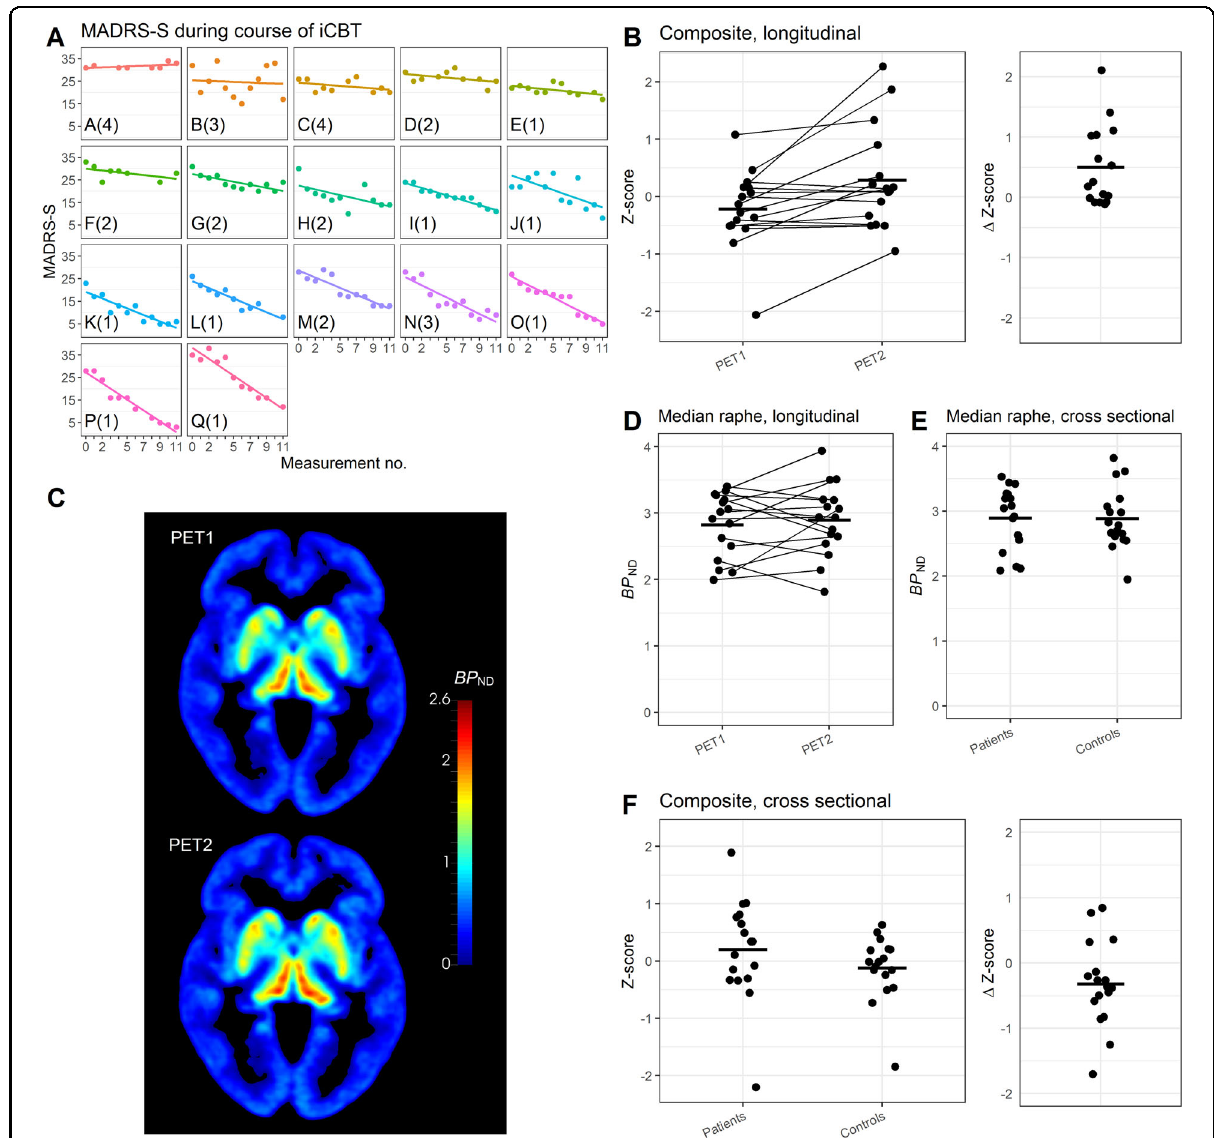
Fig. 3 MADRS-S and PET data. In A MADRS-S measurements during the course of ICBT. Each cell represents one patient, ( n = 17), letters in lower left corner corresponds to the letters in Fig. 1, numbers in parenthesis is CGI-I. In B longitudinal [ 11 C]MADAM data ( n = 16) for the composite region, PET1 (baseline) and PET2 (after treatment). Right panel shows difference scores between scans. In C mean parametric image of patients at baseline (upper image) and after treatment (lower image; n = 16), see Supplement 3 for a 3D movie of the same data. In D longitudinal data, median raphe, BP ND at PET1 (baseline, left) and PET2 (after treatment, right). In E cross-sectional data, median raphe, BP ND for patients with MDD at baseline (left) and healthy controls (right). In F cross-sectional [ 11 C]MADAM data ( n = 17 + 17) for the composite region, comparing patients with MDD at baseline to matched healthy controls. Right panel shows difference scores between matched